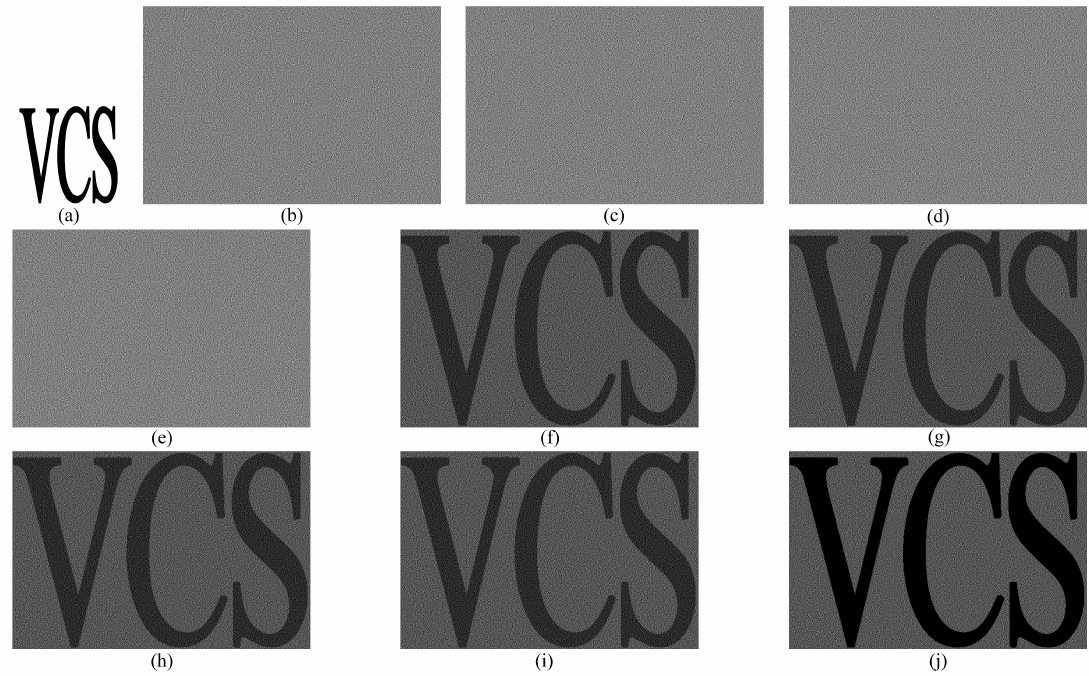
Figure 1. The experimental results of (3, 4)-VCS. ( a ) the secret image; ( b – e ) four generated shadows; ( f ) revealed image by shadow 1, 2 and 3; ( g ) revealed image by shadow 1, 2, and 4; ( h ) revealed image by shadow 1, 3, and 4; ( i ) revealed image by shadow 2, 3, and 4; and, ( j ) revealed image by shadow 1, 2, 3, and 4.